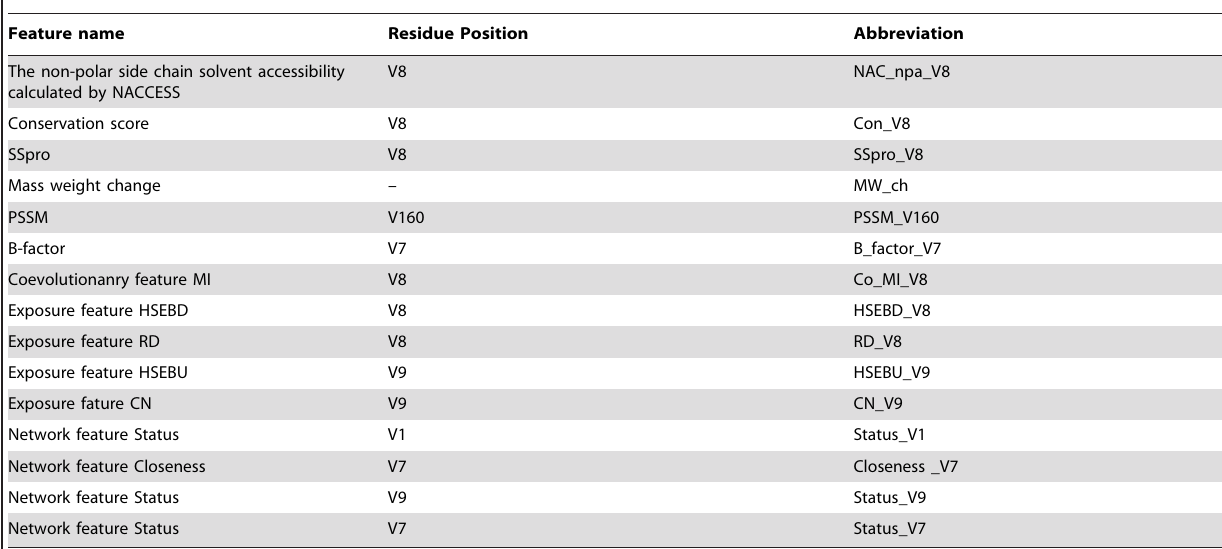
Table 2. Abbreviations of the 15 final selected features in this